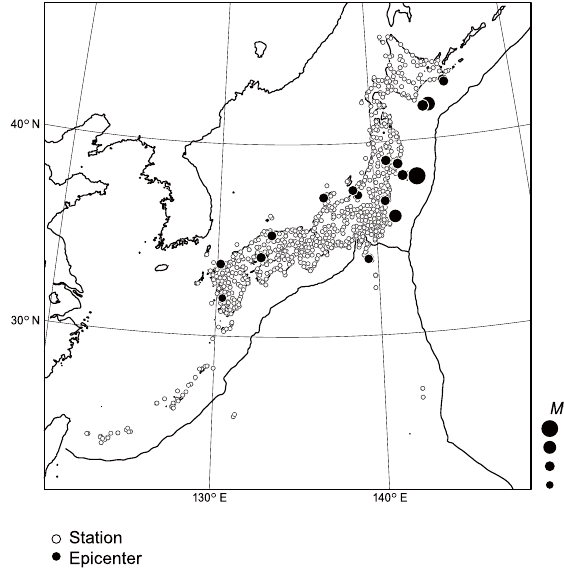
Figure 2. Station and epicenter map. Stations of seismic intensity meters (open circles) and epicenters of the events (solid circles) for which seismic records were used in this study are